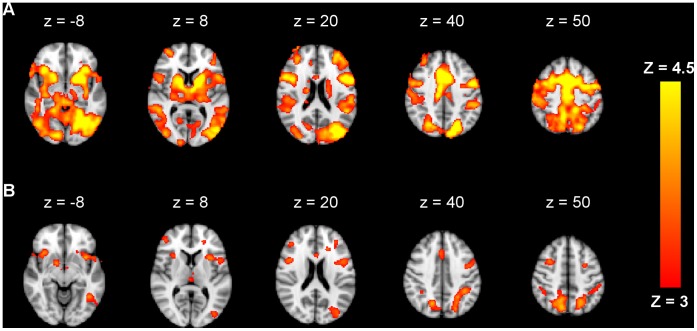
Motor task-related decrease of brain activity during and after stimulation.Activity decreased with time for contrasts run1-run2 (A) in primary and premotor cortices, supplementary motor area (SMA), prefrontal cortex, occipital cortex, thalamus and basal ganglia and run2-run3 (B) in the precuneous, superior parietal cortex, middle and inferior frontal gyrus, right prefrontal cortex, left inferior LOC and basal ganglia (Z>3, P<0.05, corrected).